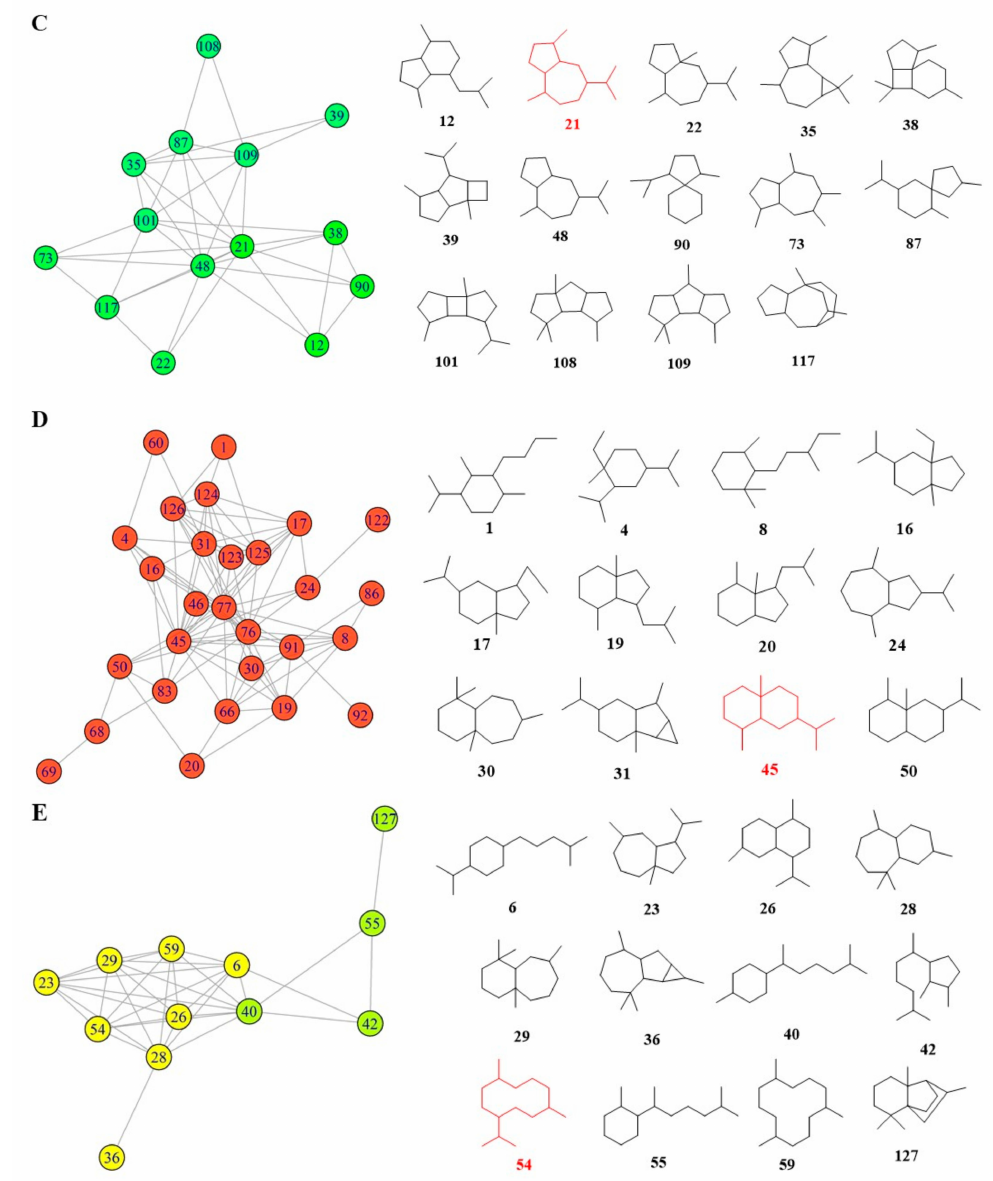
Figure 1. Network analysis identifying key sesquiterpenes. ( A ) Sesquiterpenes network graph; square nodes represent higher values of degree than other nodes (shown as circles). The sesquiterpenes were clustered by the cluster_louvain method, and their communities were colored by rainbow package (start: red, middle: green, end: green). ( B ) Community of sesquiterpenes with anti-HBV activity. Nodes 21, 45 and 54 are key sesquiterpenes. ( C ) The community with node 21 (guaiane). ( D ) The community with node 45 (eudesmane). ( E ) The community with node 54